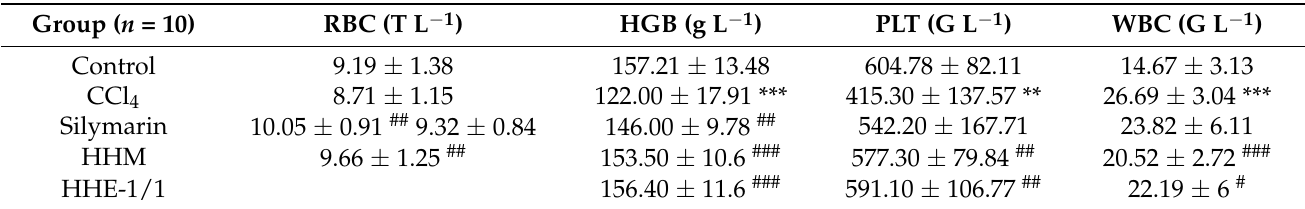
Table 1. HHM and HHE-1/1 effect on red blood cells, hemoglobin, platelets of CCl 4 -induced liver fibrosis in